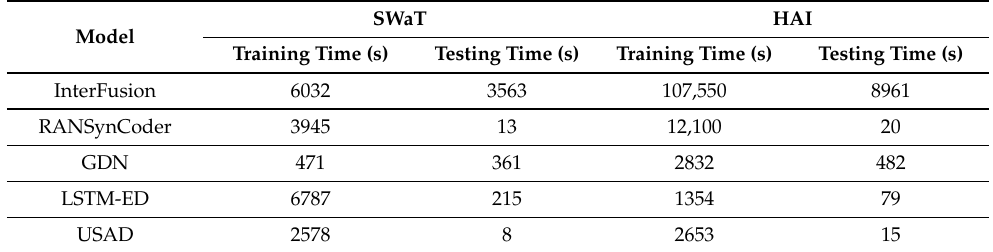
Table 7. Training and testing times of anomaly detection models in SWaT and HAI